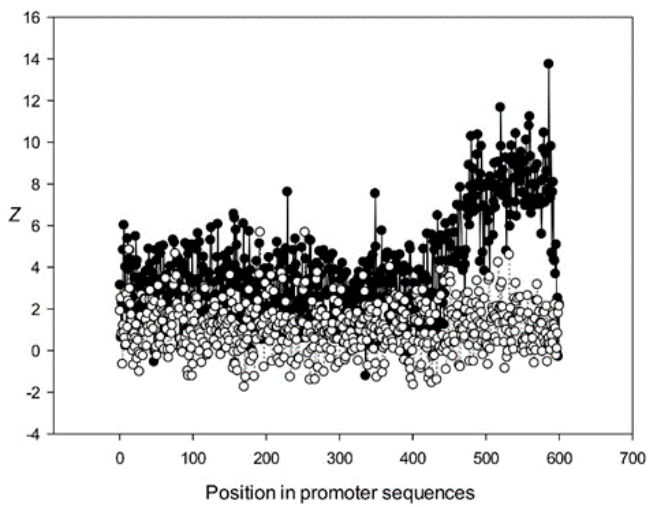
Figure 12. Dependence of Z on position l for promoter sequences of the fourth class. Black circles indicate multiple alignment for promoter sequences of the fourth class and white circles indicate randomly mixed promoter sequences where positions of indels were maintained.